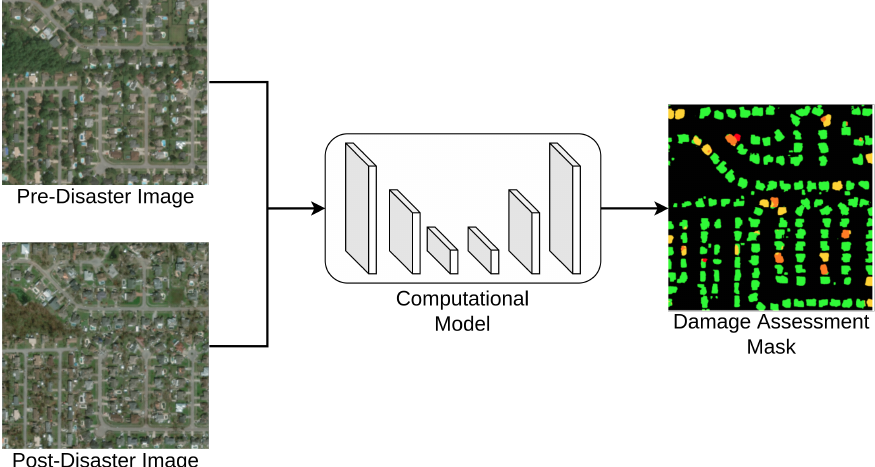
Figure 1. The illustration of the computational model for building damage